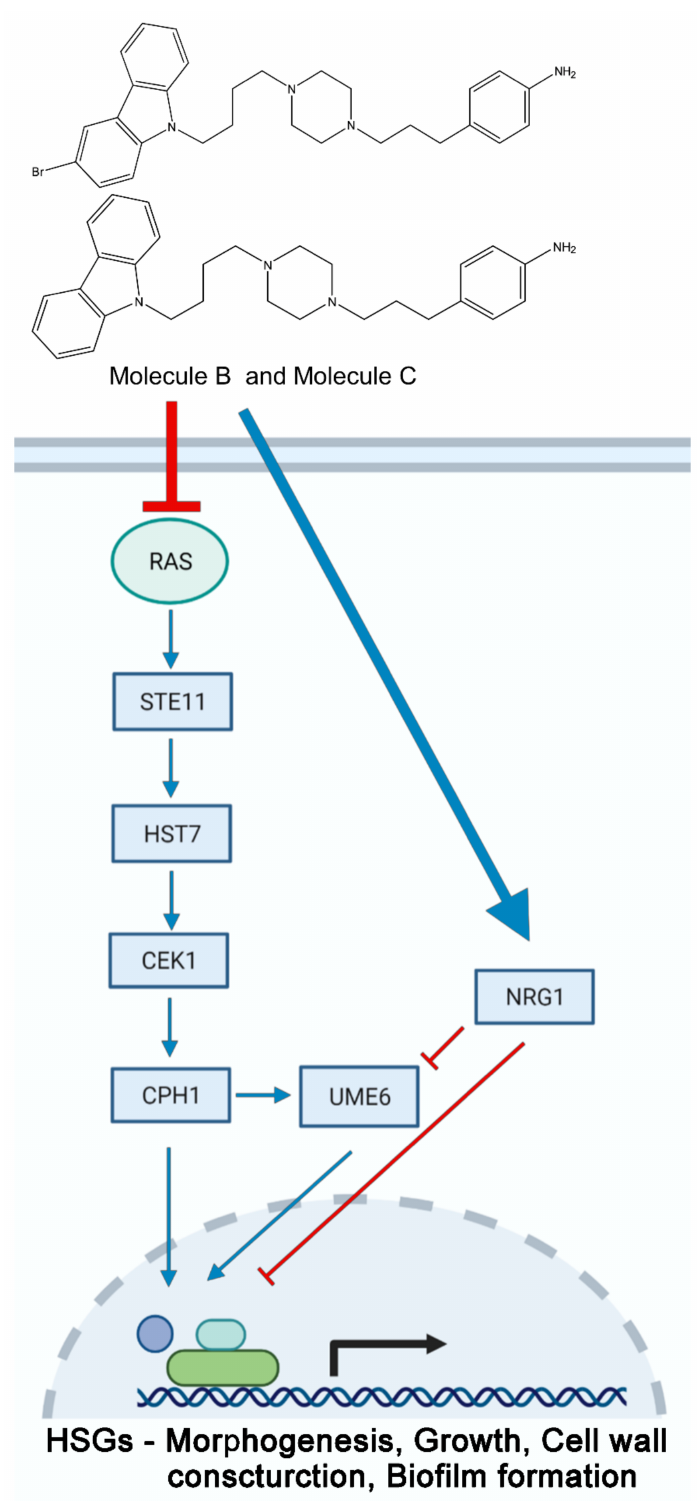
Figure 6. Putative model of virulence inhibition in C. albicans by Molecule B and Molecule C. The inhibitory effects of Molecule B and Molecule C on upstream activator signaling proteins are shown. Molecule B and Molecule C inhibit Ras1 and affect the PAK kinase Cst20, thus affecting the Cek1 MAP kinase cascade, resulting in a decrease in the levels of the transcription factor Cph1. The level of Ume6, which is regulated by the signal of Cph1, also decreases as the amount of Nrg1